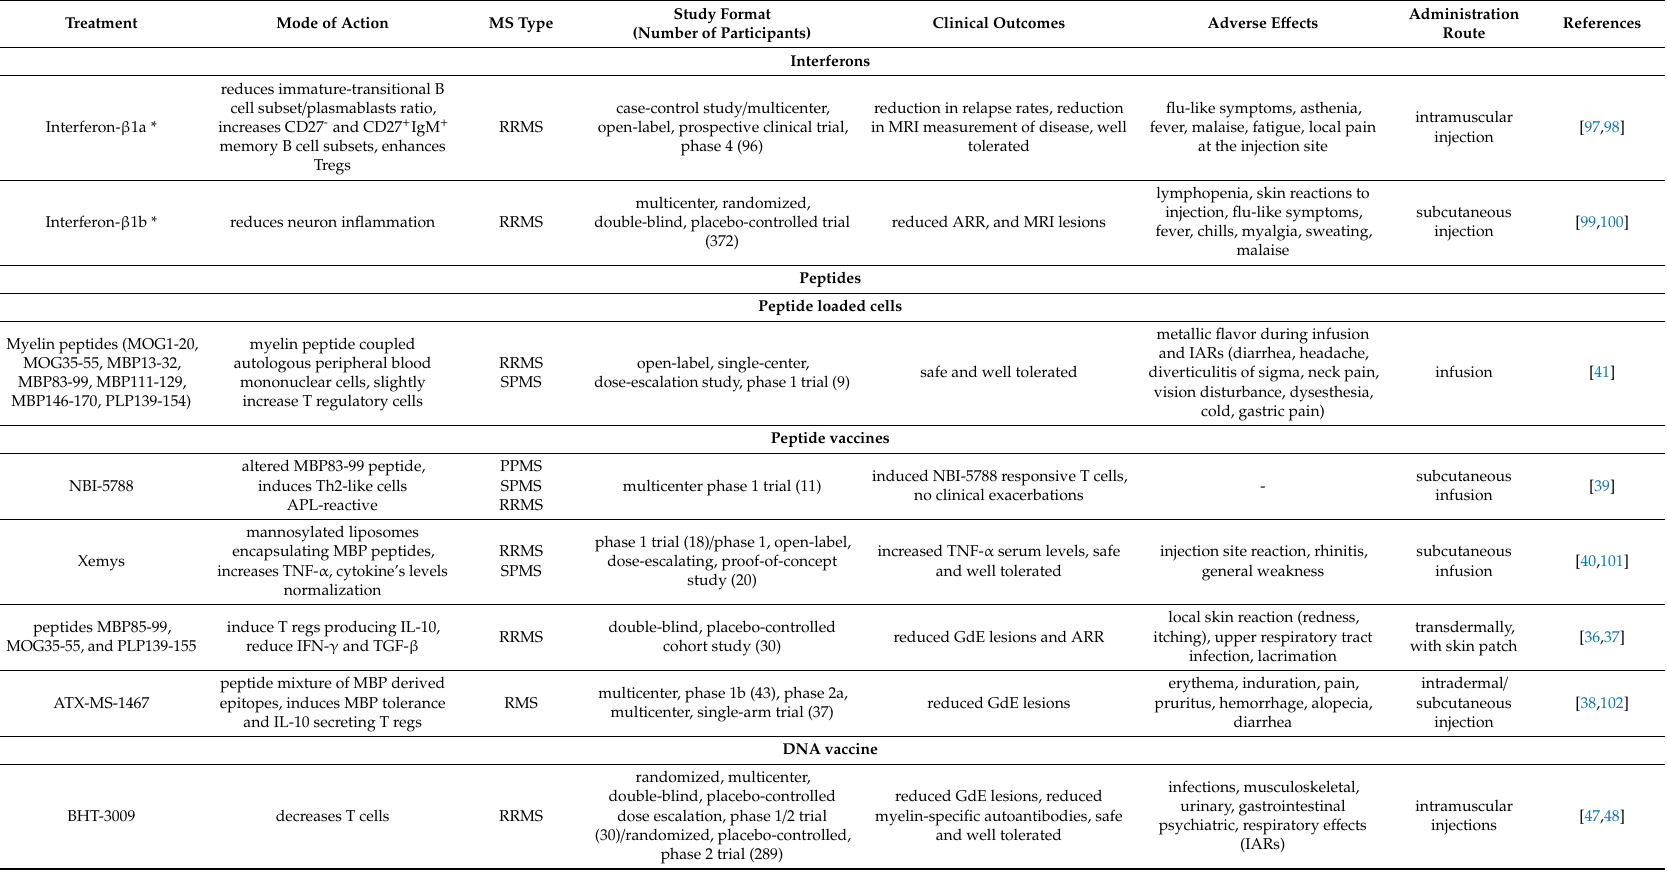
Table 1. Overview of medical treatments for multiple